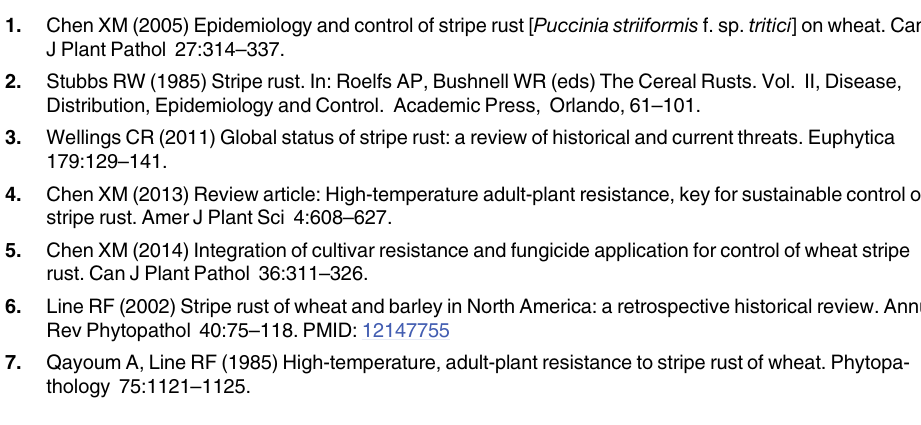
popula- S6 Dataset. Linkage groups constructed for the Druchamp X Michigan Amber F 8 tion using SSR and SNP markers. A total of 32 linkage groups representing 18 chromosomes constructed with 156 SSR and 2,535 SNP markers and their map positions and alleles in the lines. Druchamp × Michigan Amber F 8 S1 Table. Effects of different combinations of the QTL. Mean rAUDPC and IT in six field ex- periments (Pullman 2006, 2010 and 2011 and Mt. Vernon 2005, 2010 and 2011) in the Druchamp × Michigan Amber RIL